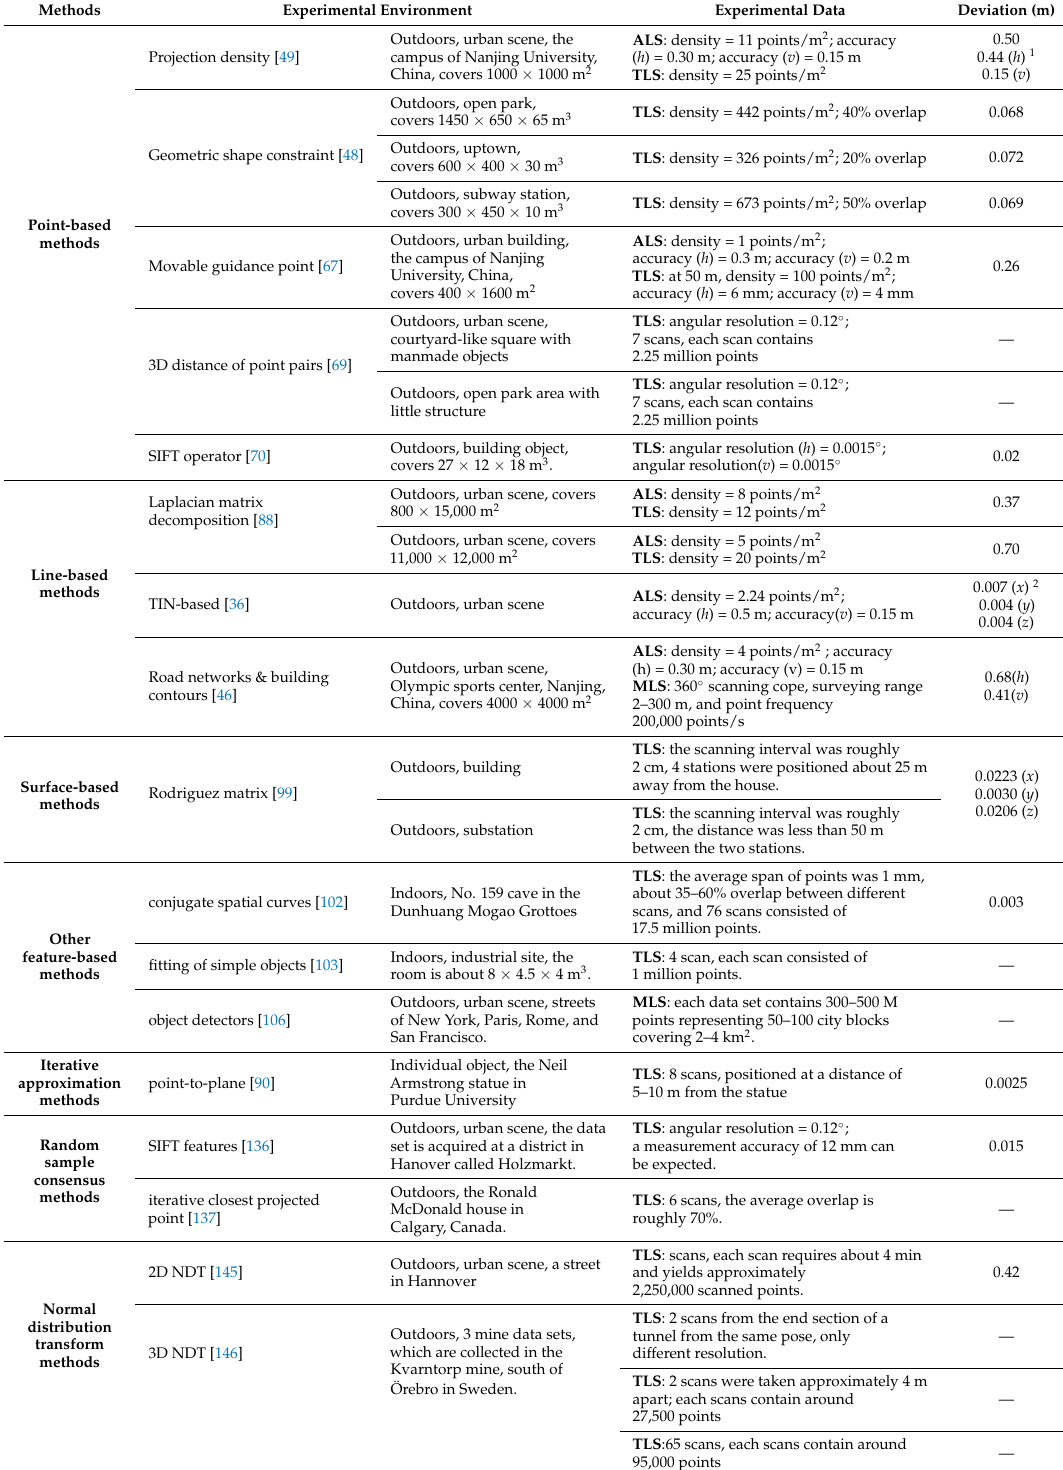
Table 7. The applications and performances of different registration